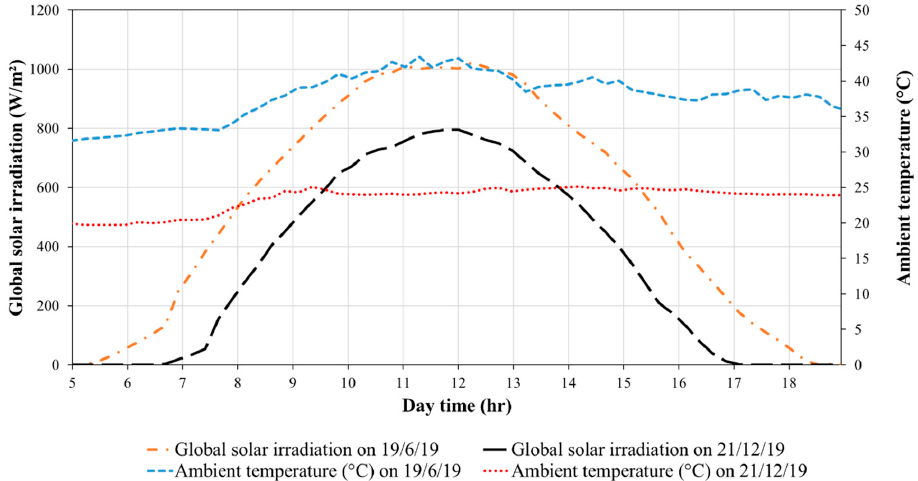
Figure 6. Actual global solar irradiation and the ambient temperature during the longest day (19 June 2019) and the shortest day (21 December 2019) in Muscat.